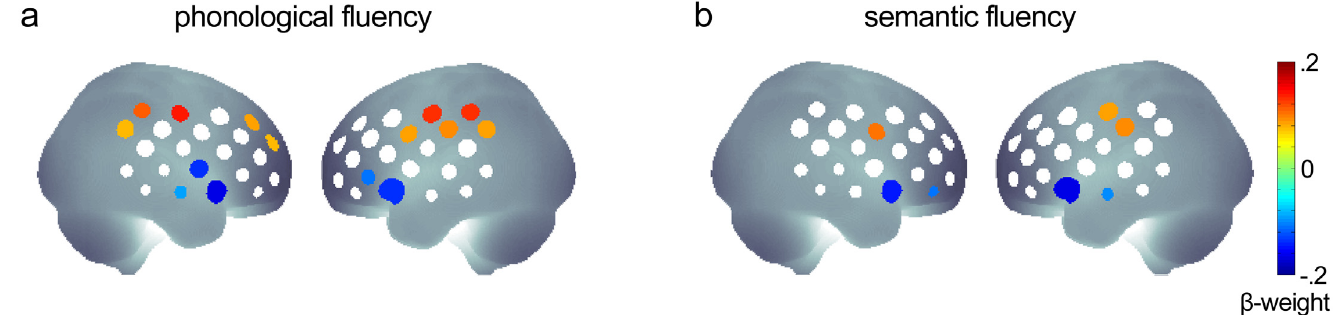
Fig 2. Standardized β -weights of the predictor age in multiple regression analyses of hemodynamic responses in the replication sample of 727 individuals (a/b) and the initial sample (c/d; n = 325). Channels with significant (FDR-corrected) prediction of hemodynamic responses by age during (a) phonological fluency, and (b) semantic fluency. Regression models included the predictors age, sex, years of education and task performance.